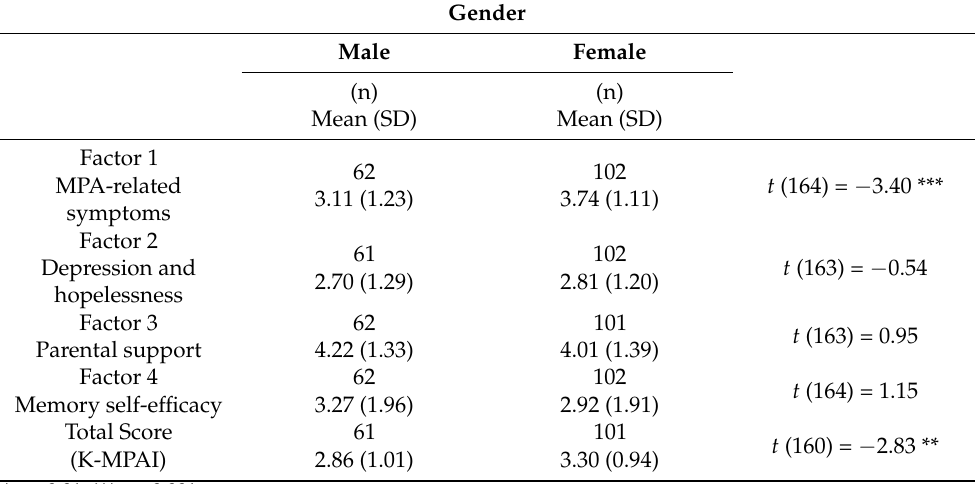
Table 4. Gender differences related to MPA (dimensions and total